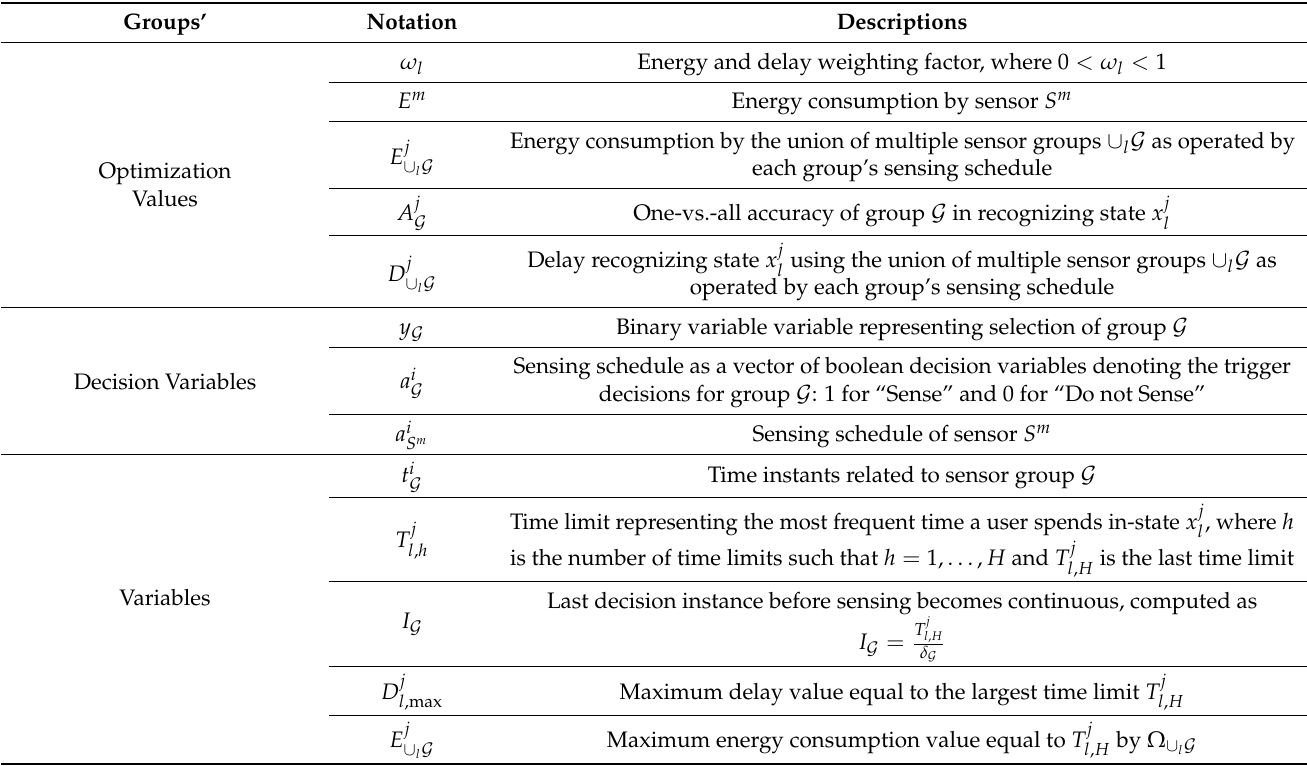
Table A2. Three scenarios in “Walk” state detection with time limits of T 1